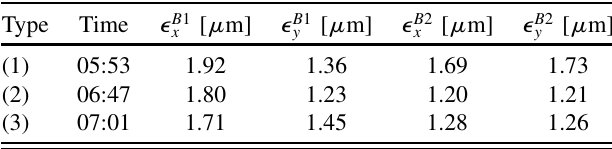
TABLE V. Normalized, 1 (cid:5) wire-scan emittances: (1) noncol- liding beams before scraping, (2) noncolliding beams after scraping, and (3) colliding beams before scraping.